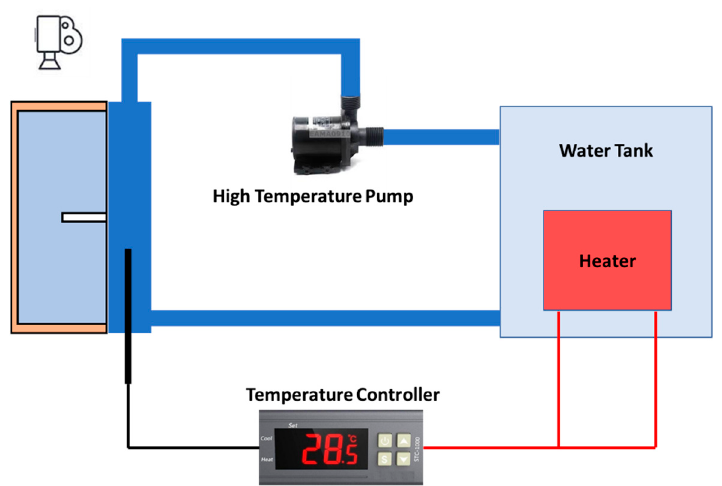
Figure 4. Experimental setup.